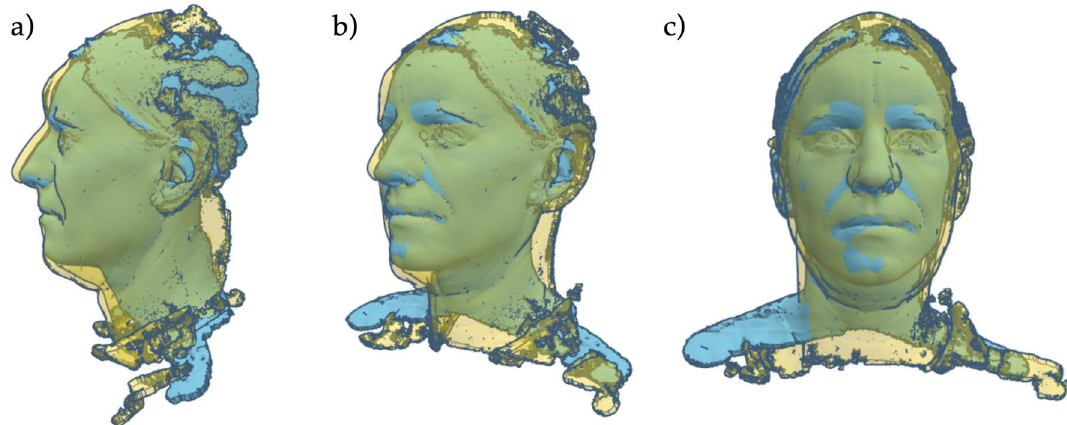
Figure 11. Overlaying two face scans, showing the differences in shape and size from different views: (a) the left, (b) front left and (c)